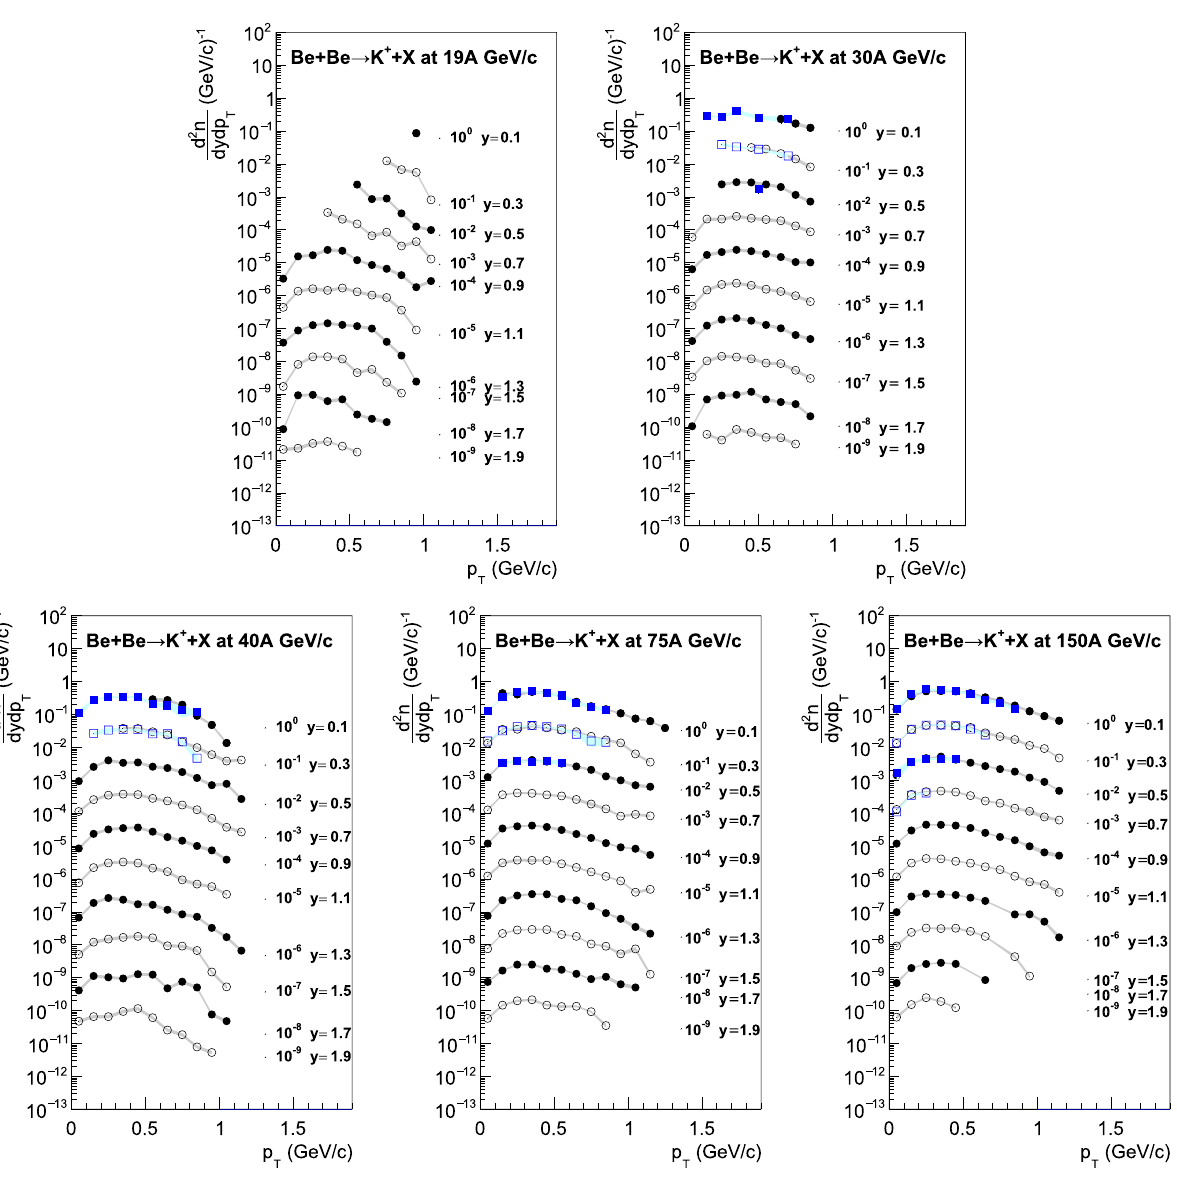
Fig. 20 Transverse momentum spectra in rapidity slices of K + pro- duced in the 20% most central Be+Be collisions. Rapidity values given in the legends correspond to the middle of the corresponding interval.